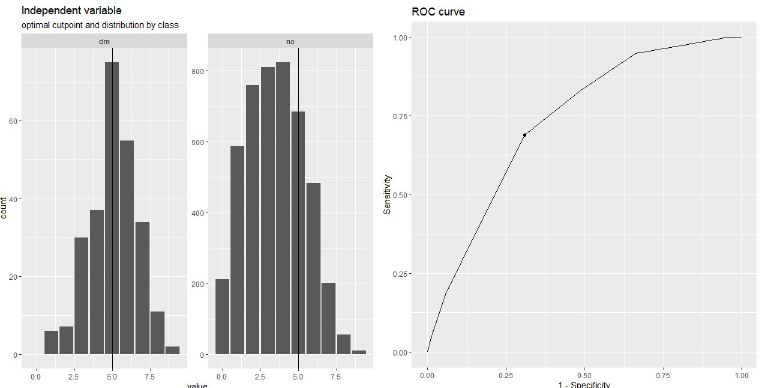
Fig 11. Benchmarking with the ADA diabetes risk test. Comparison of predictive performance of ADA diabetes risk test on internal validation data (AUC = 0.737028) and the best-performing predictive model on internal validation data (AUC = 0.7566544), as per DeLong test for comparing two ROC curves, was non-significant (p = 0.3201) indicating performances on a par with each other. Comparison of predictive performance of ADA diabetes risk test on external validation data (AUC = 0.7401352) and the best-performing predictive model on external validation data (AUC = 0.7464), as per DeLong test for comparing two ROC curves, was also non-significant (p =